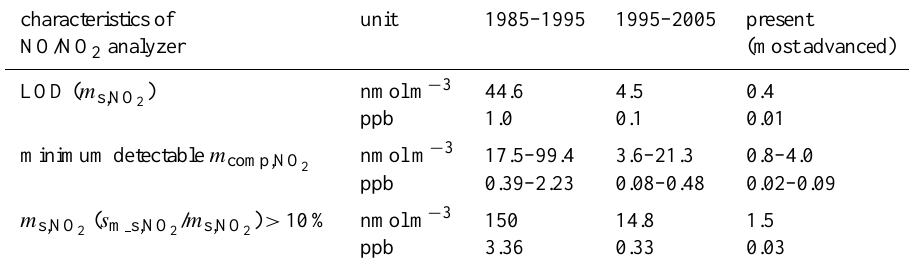
Table 1. Review of the specifications of NO/NO 2 analyzers under well defined (laboratory) conditions. Results are from data simulations (random number application), for details of simulation conditions see text (Sect. 2.2). Ranges of minimum detectable NO 2 compensation point concentrations ( m comp,NO ), correspond to ranges of NO 2 deposition velocity and the goodness ( R 2 ) of relation between the ambient 2 vs. sample NO 2 concentration measurements. Sample NO 2 concentrations ( m s,NO ments (= s m,s NO / m s,NO ) exeeds the 10% level, are also 2 2